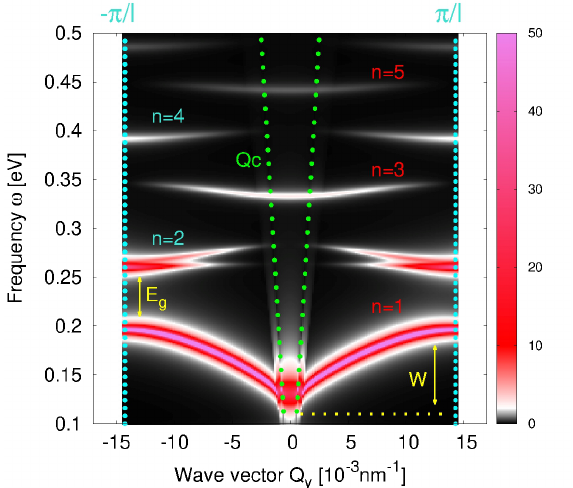
Figure 7. The absorption intensities A (in units 2 π e 2 / h ) in an array of KC 8 -NR deposited on a dielectric model Al 2 O 3 surface for Q y ∈ [ − π / l , π / l ] showing the DPR band structure. The nanoribbons width is d = 200 nm, the period is l = 220 nm and z 0 = 3.0 Å. Green doted lines denote the photon dispersion relation ω = Qc . Turquoise dotted lines denote the 1stBZ